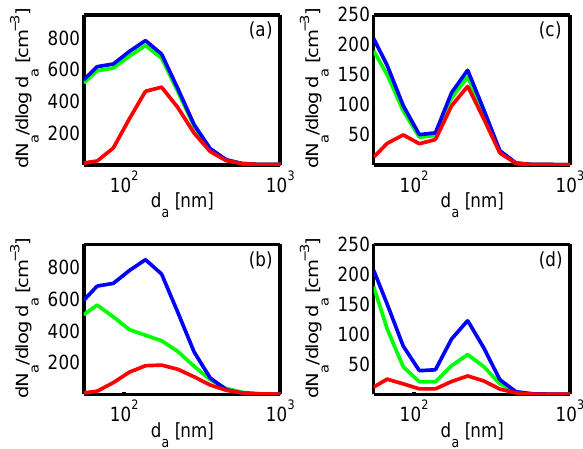
Fig. 12. Particles larger than 0.055µm for HIGH (a, b) and LOW (c, d) Lagrangian cloud model cases after 2 h (top) and 8 h (bottom) of run time. Analogous to Fig. 10, the blue line shows the aerosol size distribution below the cloud, averaged between 100–350 m in height, while the red line represents the particles only present within droplets larger than 8µm in size. The green line shows all particles within the cloud layer, including both interstitial and in-cloud parti- cles. In-cloud was defined as points with q c > 10 − 3 g kg − 1